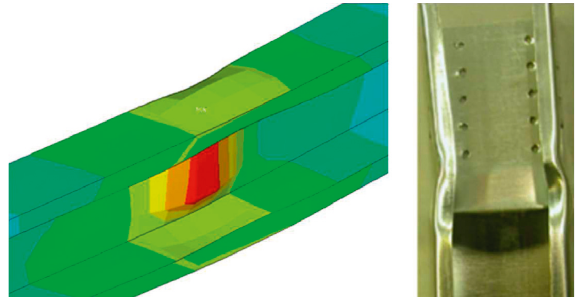
Figure 8: Comparison of local failure mode between test and FEA for 300 and 600mm